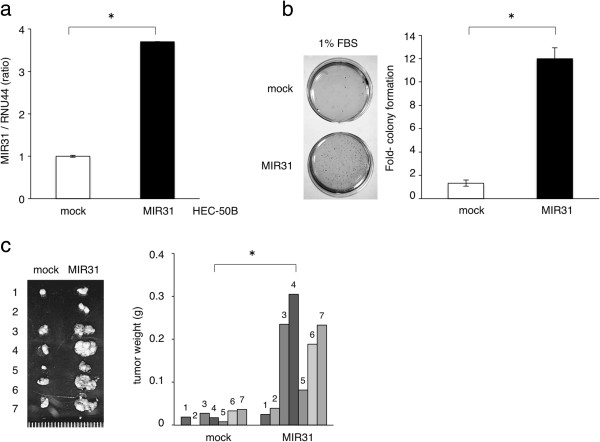
The overexpression of MIR31 enhanced tumorigenesis in vitro and in vivo. (a) Establishment of HEC-50B-expressing MIR31 cells. The results of the qRT-PCR analysis of the expression levels of MIR31 are shown in the bar graph. *p < 0.05, unpaired two-tailed Student’s t-test. The experiments were performed in triplicate. (b) Colony formation assay with 1% FBS. Representative stained colonies are displayed in the left panel. *p < 0.05, unpaired two-tailed Student’s t-test. The experiments were performed in triplicate. (c) Subcutaneous tumors in the seven nude mice are displayed in the left panel. The weights of tumors are shown in the right bar graph. *p < 0.05, paired two-tailed Student’s t-test.